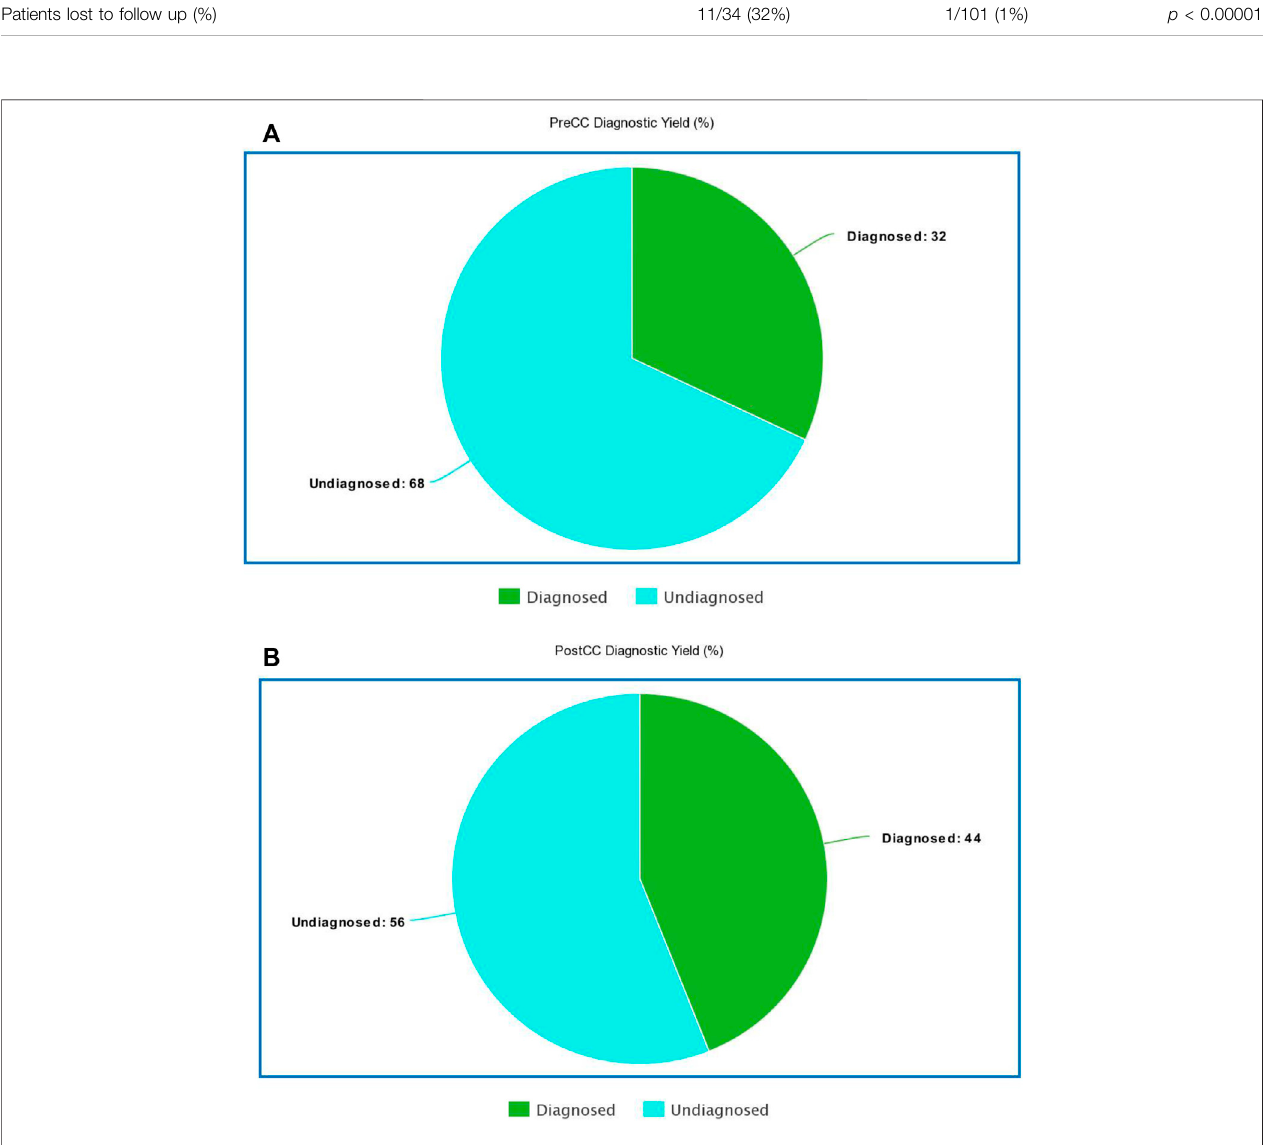
FIGURE 1 | (A) : Diagnostic yield in PreCC 1 (B) : Diagnostic yield of PostCC.